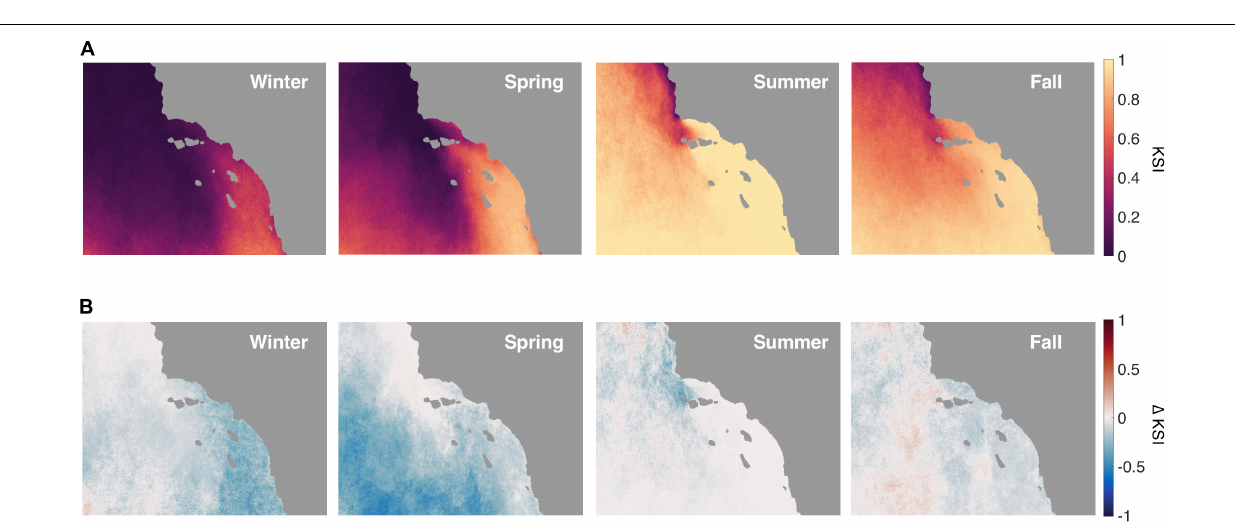
FIGURE 12 | (A) The Kelp Stress Index (KSI) for each season over the study area. The KSI is the proportion of the season where kelp is nutrient stressed. Nutrient stress is defined as greater than 21 consecutive days of seawater nitrate concentration less than 1 µ mol L − 1 . (B) The difference in the KSI for each season when the North Pacific Gyre Oscillation (NPGO) is in a positive versus a negative